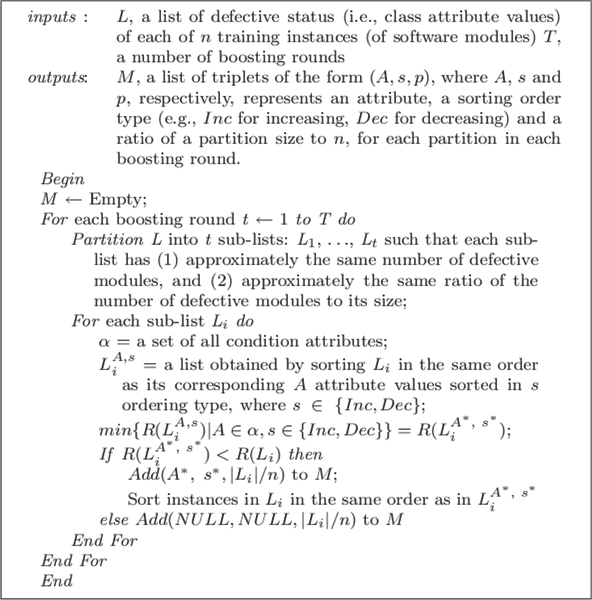
Basic steps of MDR